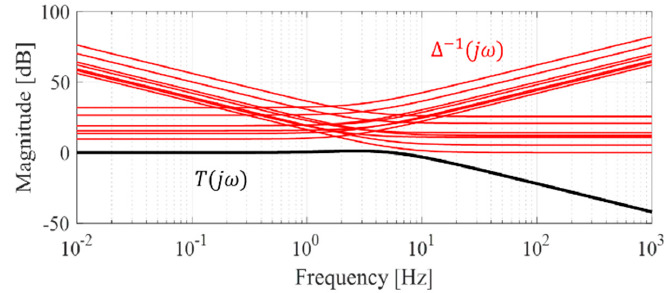
Figure 7. Frequency magnitude response for small-gain theorem check.